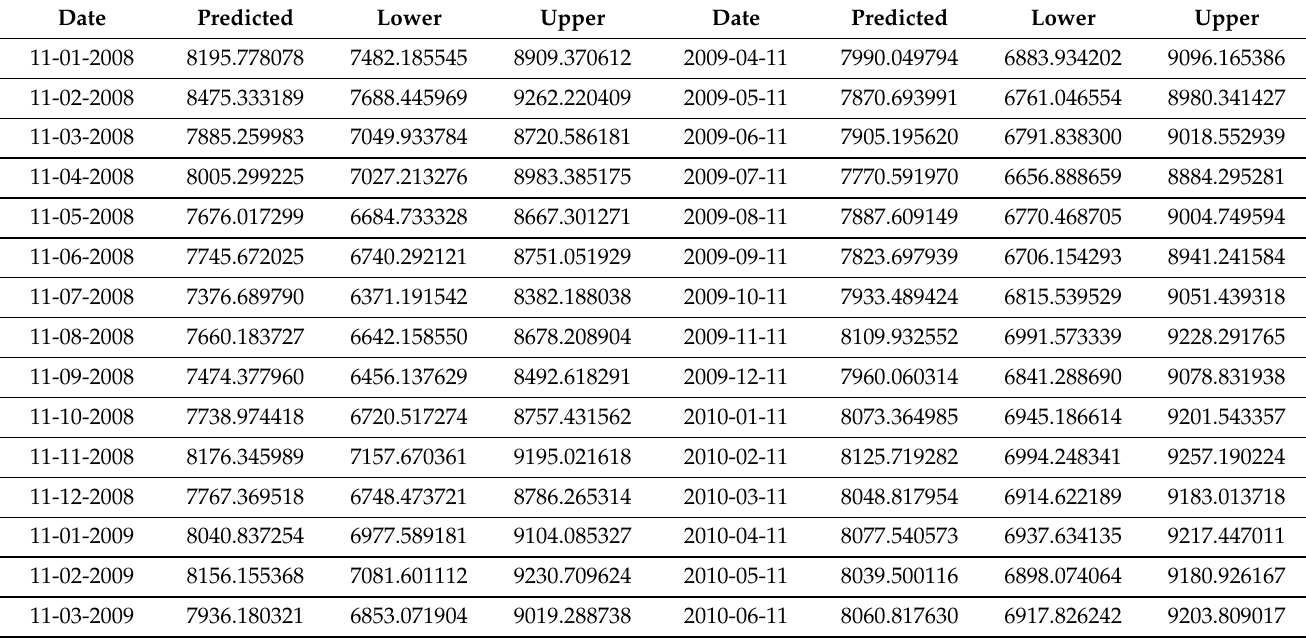
Table 5. Forecasted values of daily confirmed cases for 30 months using a SARIMA ( 1,0,2 ) × ( 1,0,0,3 ) model with 95%